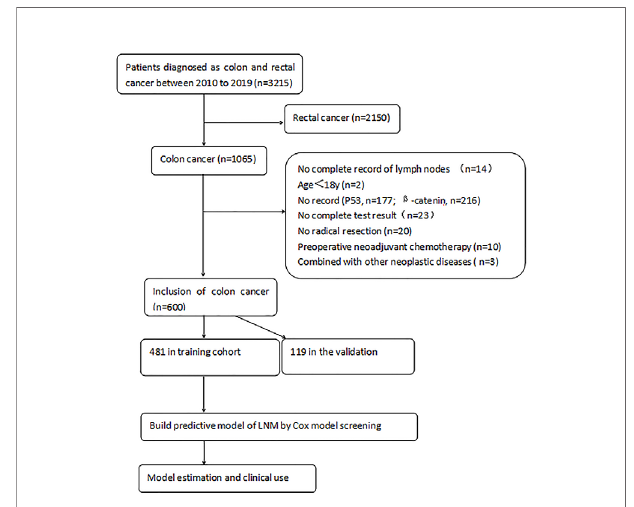
FIGURE 1 | Data screening